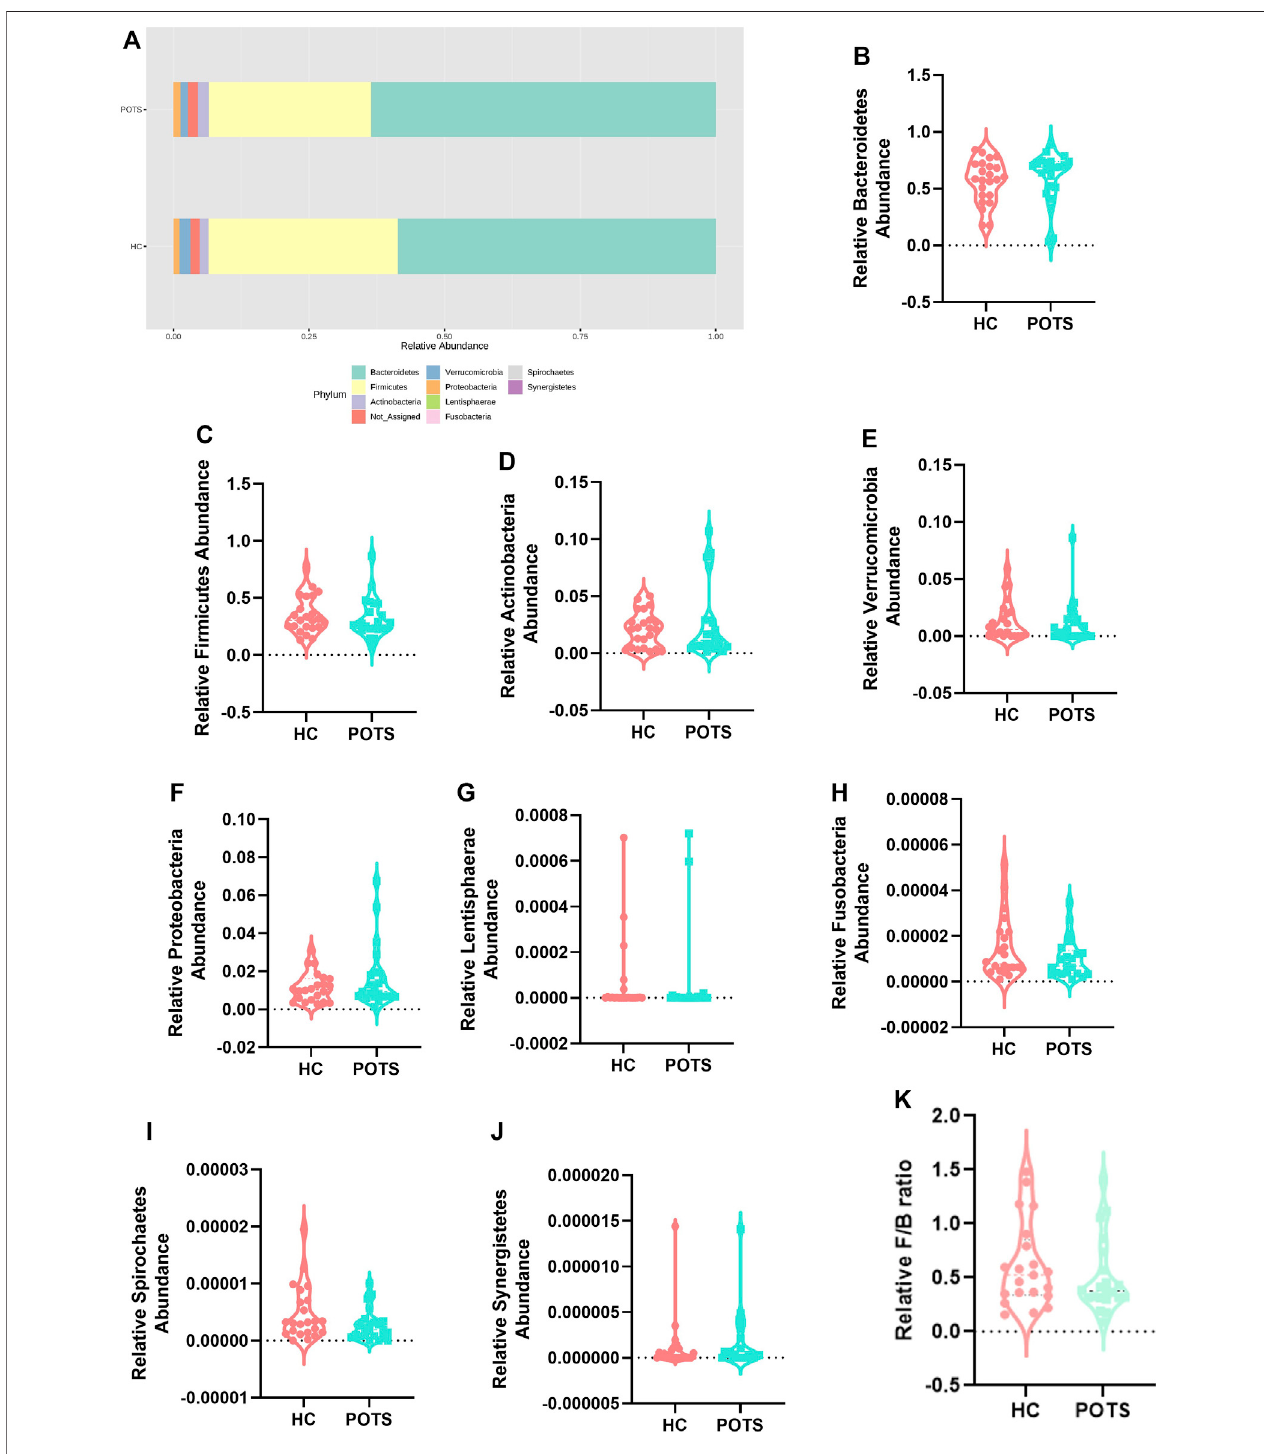
FIGURE 5 | POTS patients do not exhibit dysbiosis at the phylum taxonomic classi fi cation. (A) Stacked bar plot depicting the relative abundance of phyla in POTS and healthy control participants. Relative abundance of the phyla (B) Bacteroidetes; (C) Firmicutes; (D) Actinobacteria; (E) Verrucomicrobia; (F) Proteobacteria; (G) Lentishphaerae; (H) Fusobacteria; (I) Spirochaetes; (J) Synergistetes;and (K) FirmicutestoBacteroidetesratio.Dataarepresented asmean±SEM.Statisticalanalyses were performed using Student ’ s t -test. N = 25 for POTS and N = 23 for healthy control participants and p < 0.05 was set for statistical signi fi cance.